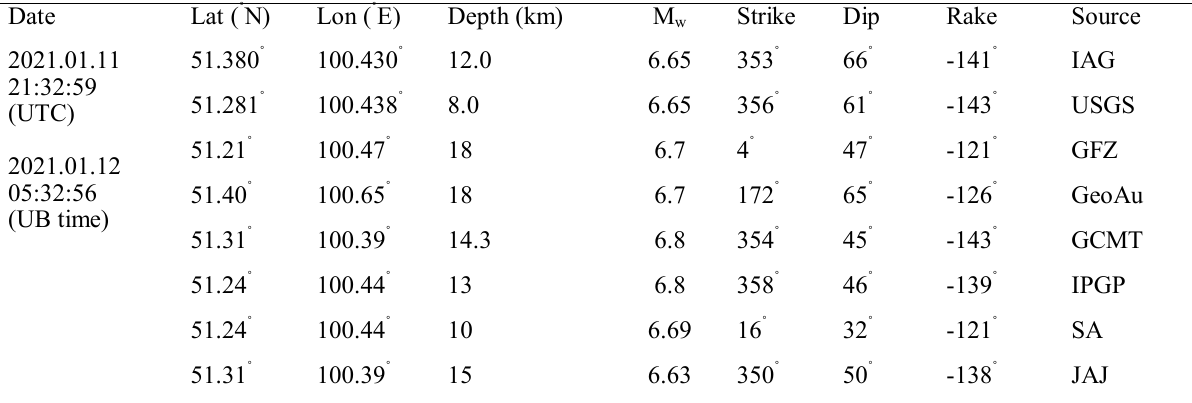
Table 1. Moment tensor solutions for the Khankh